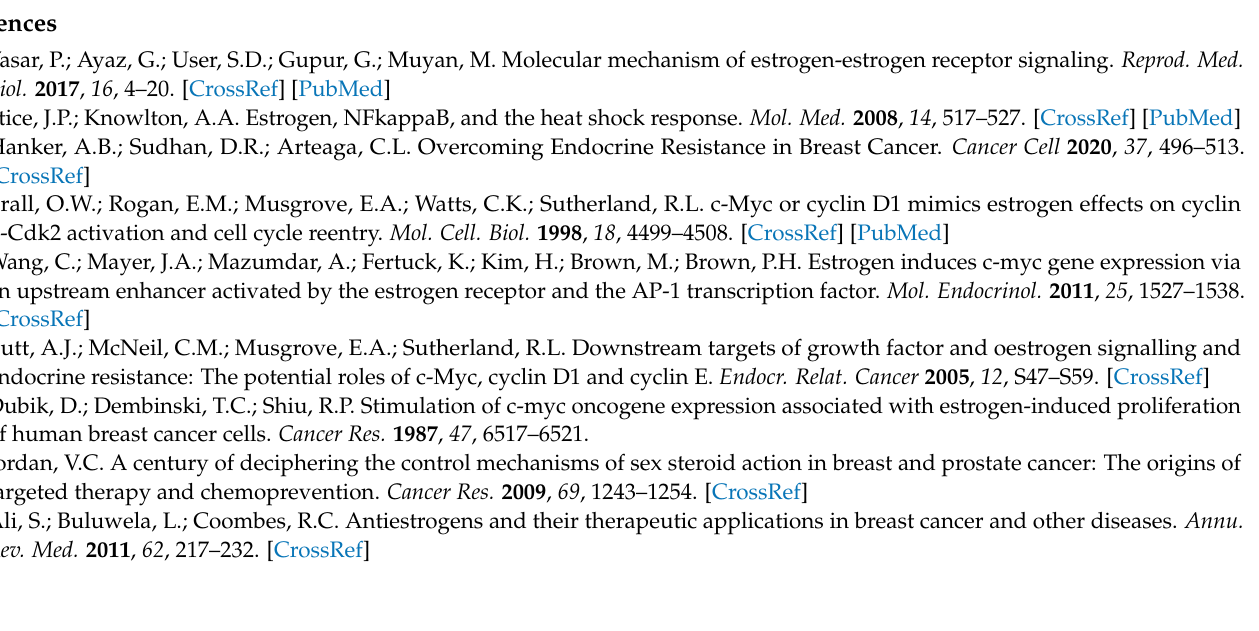
Figure S4: A-485 and EP300 genetic knockdown commonly repress ER target genes in MCF-7 cells, Figure S5: A-485 and EP300 KD reduce expression of genes that are upregulated in luminal BC, Figure S6: ChromHMM Analysis in MCF-7 cells, Figure S7: A-485 reduces H3K27ac at ER target genes but increases H3K27ac at a subset of genes, Figure S8: A-485 reduces H3K27ac at active enhancers associated with genes that are upregulated in luminal BC, File S1: list of primers used in qPCR, File S2: Raw western blot